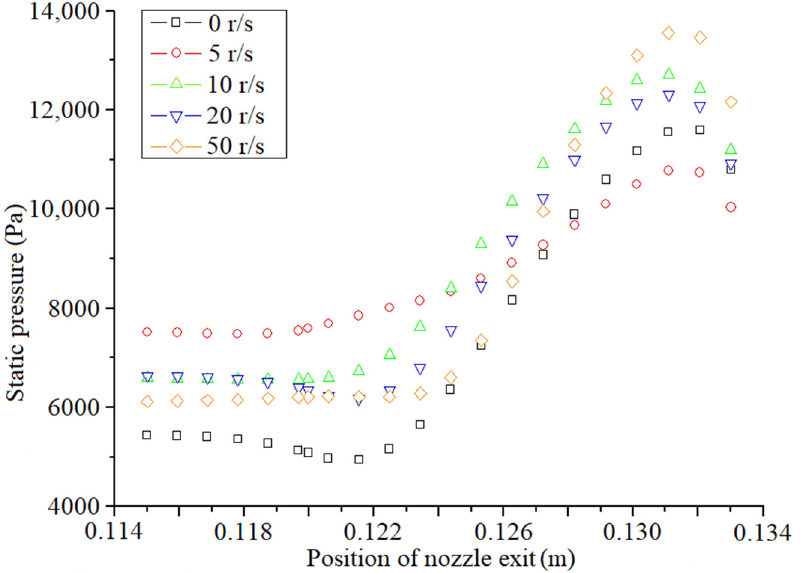
Figure 21. Static pressure distribution of the left nozzle exit at different rotational angular veloci- ties.